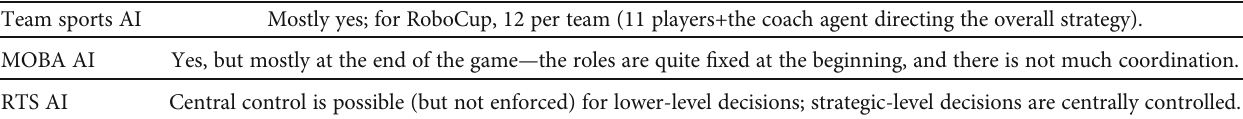
Table 2: Unit diversity property. Does the AI have to fi nd suitable ways to combine di ff erent units or to counter the enemy strategy? Team sportsAI MOBA AI